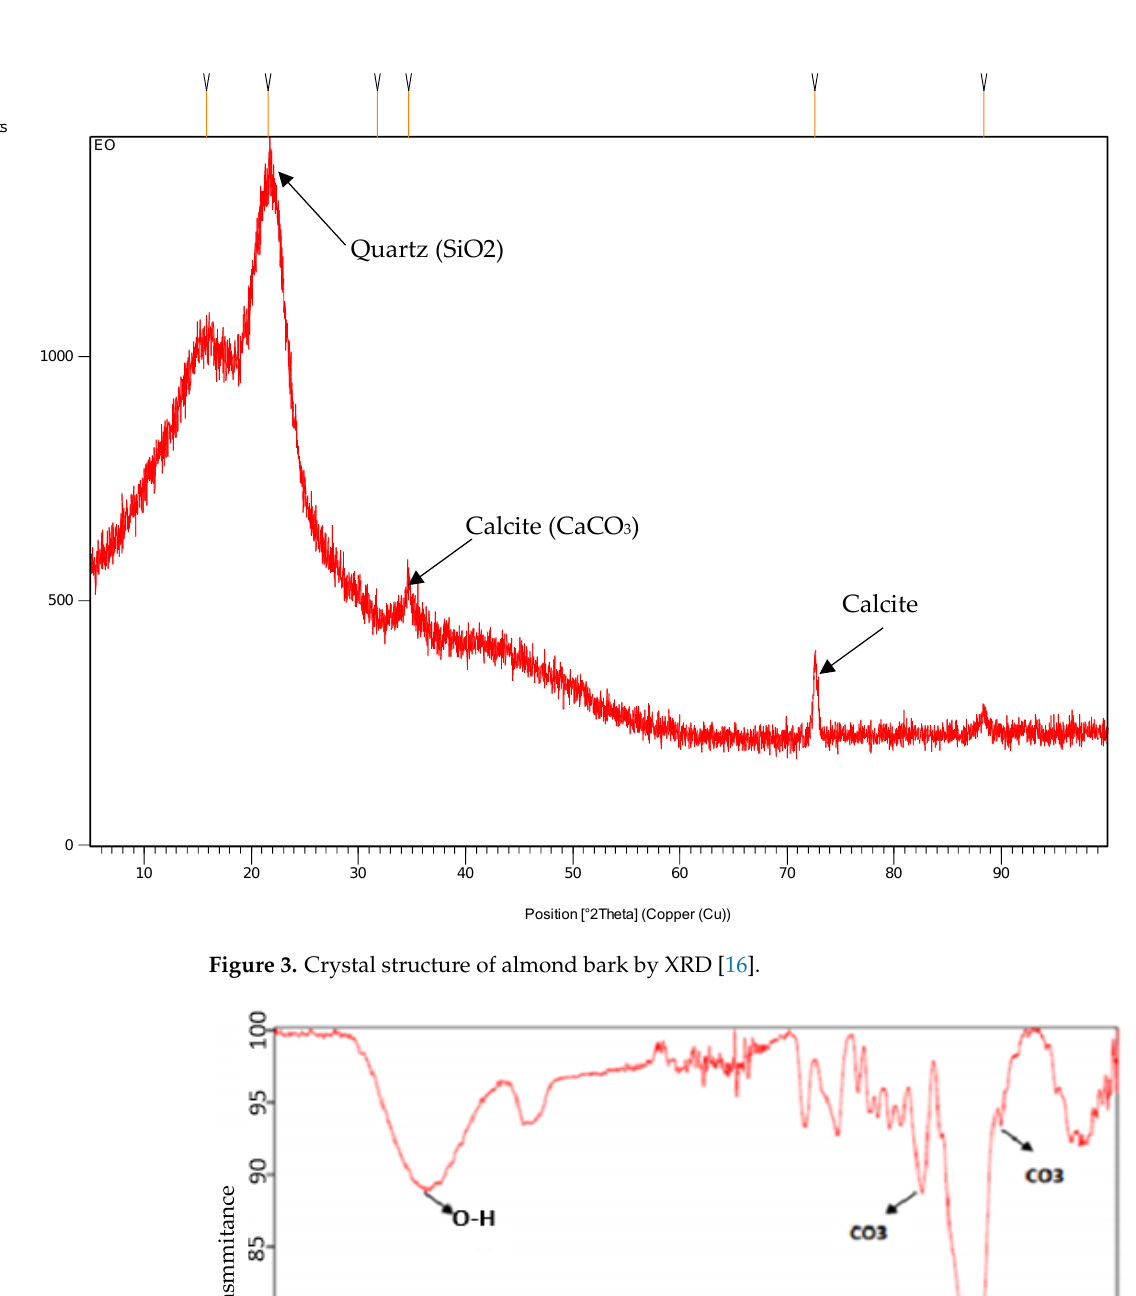
Figure 4. Infrared analysis of almond Figure 8. Infrared analysis of almond shell.